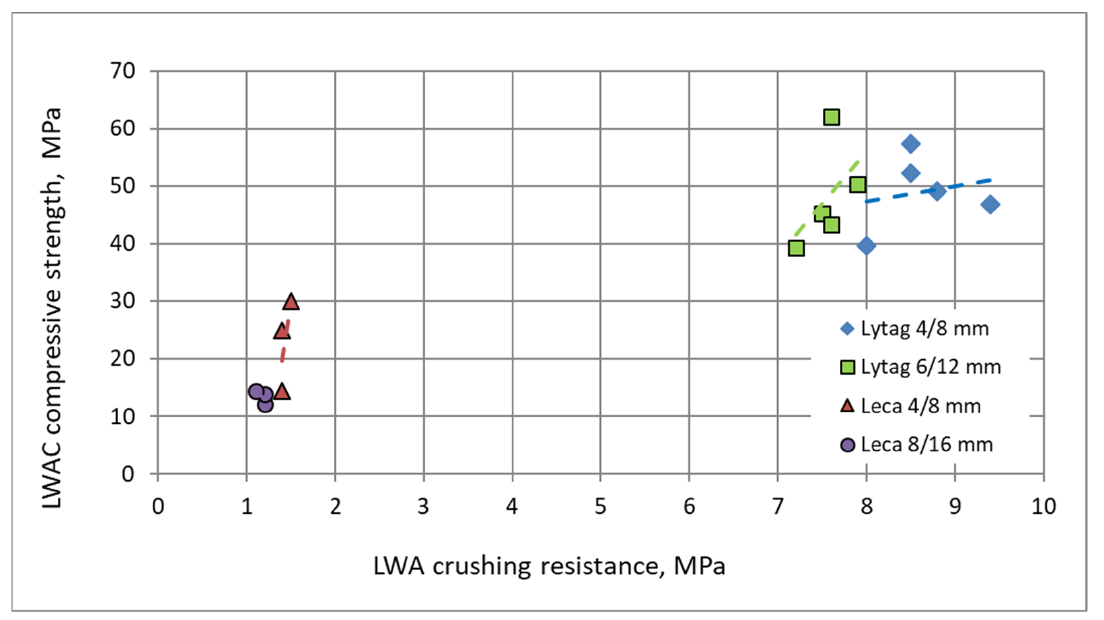
Figure 11. Relationship between mean crushing resistance of lightweight aggregates and mean compressive strength of composites.